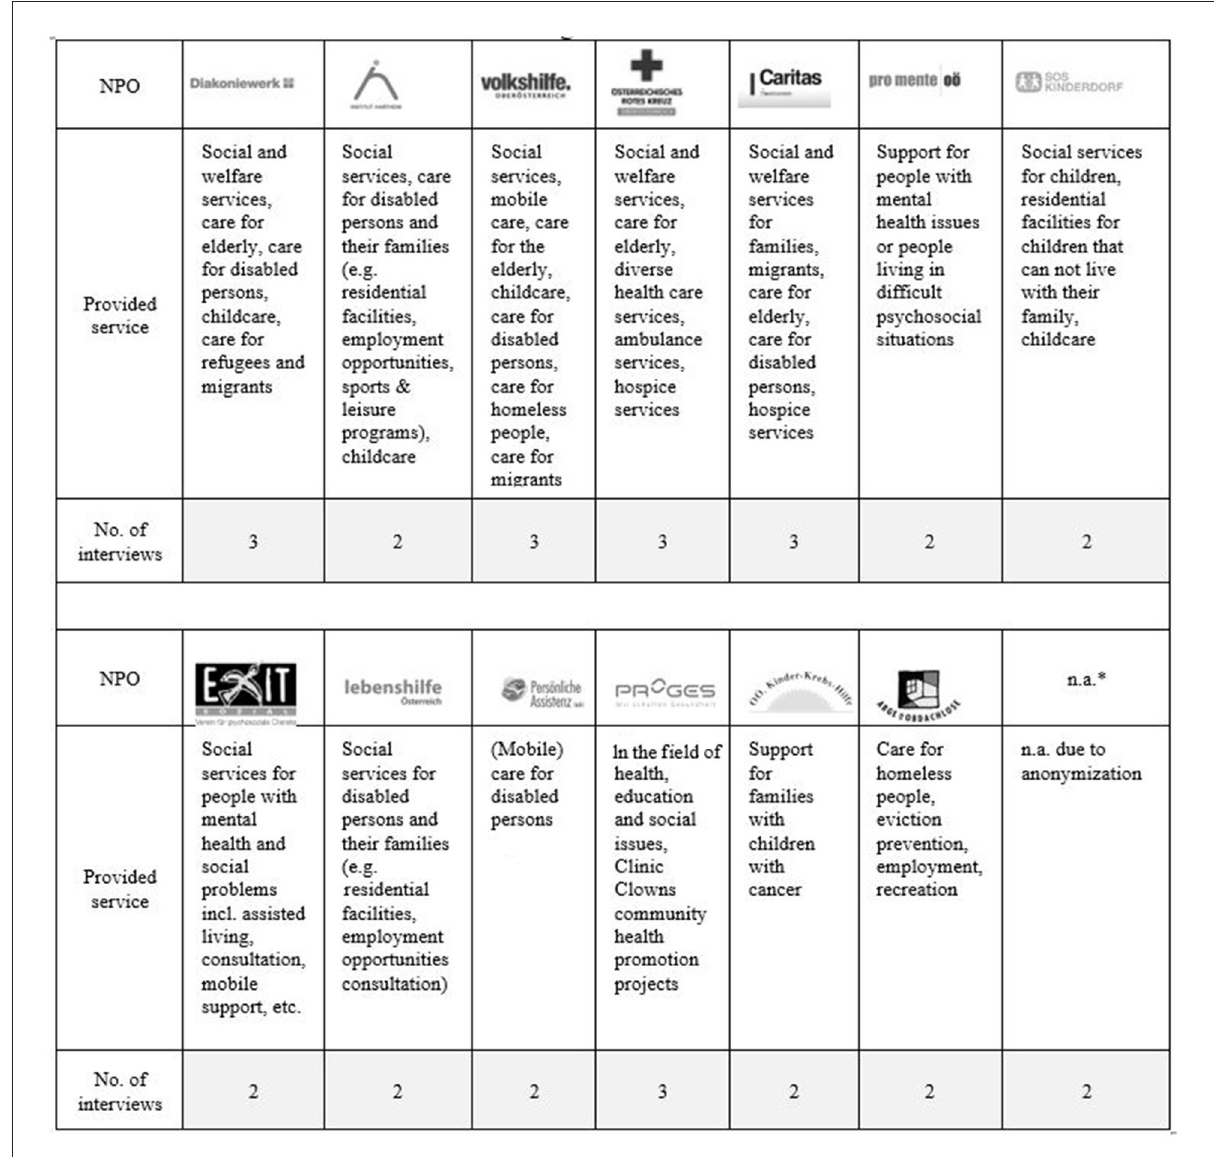
FIGURE1 Sample of the